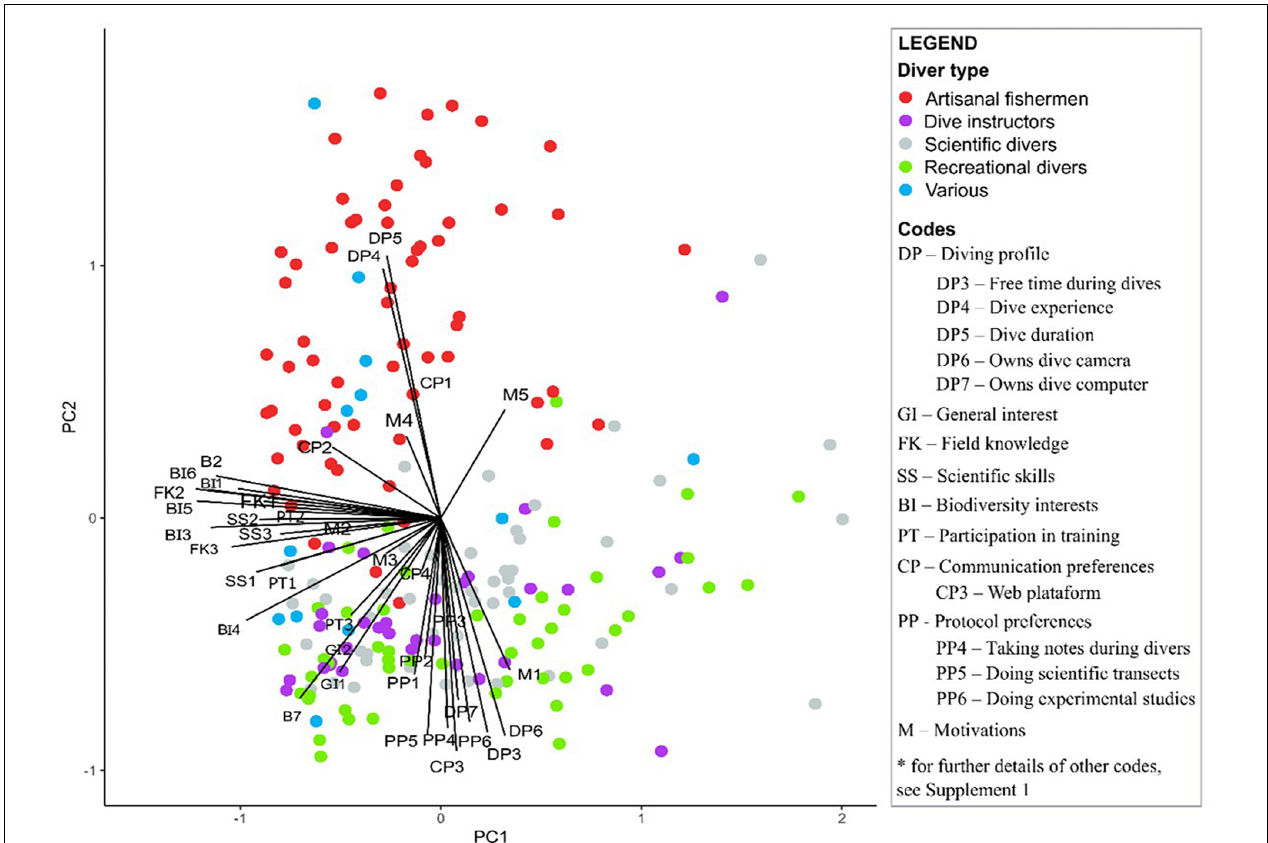
FIGURE 2 | PCA showing diving profile, interest, and preferences in CS by diver